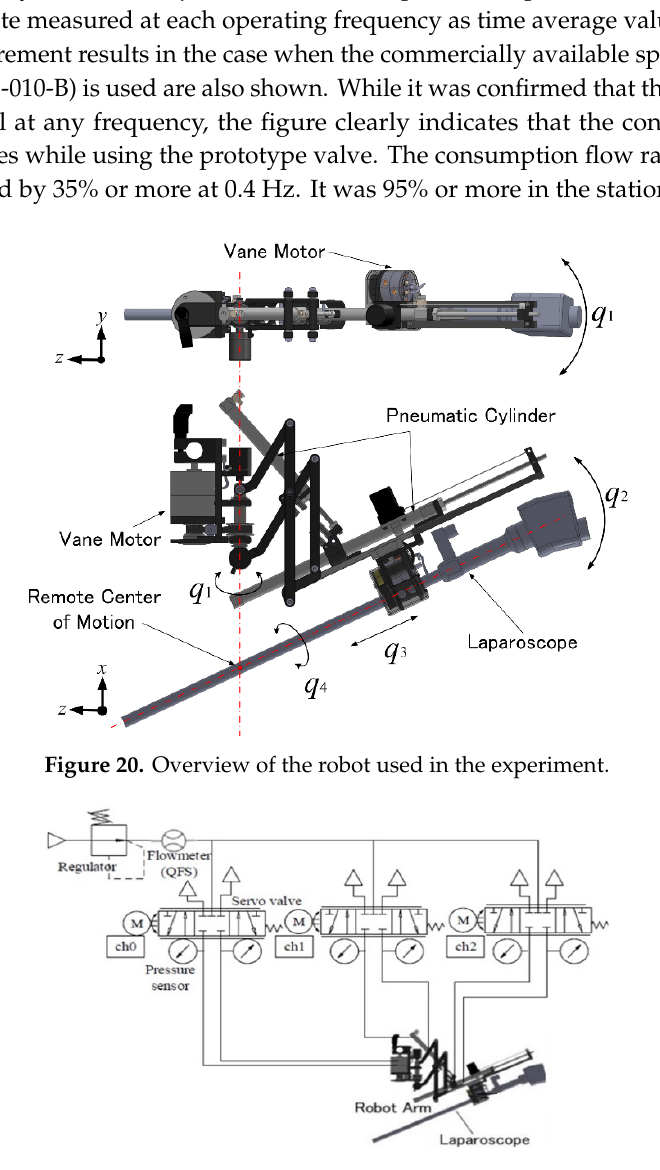
Figure 22. Air consumption. In the spool-type servo valve, there was no difference in the consumption flow rate at 0 and 0.1 Hz. It did not depend on the driving speed, and thus, it was confirmed that the leakage flow rate was